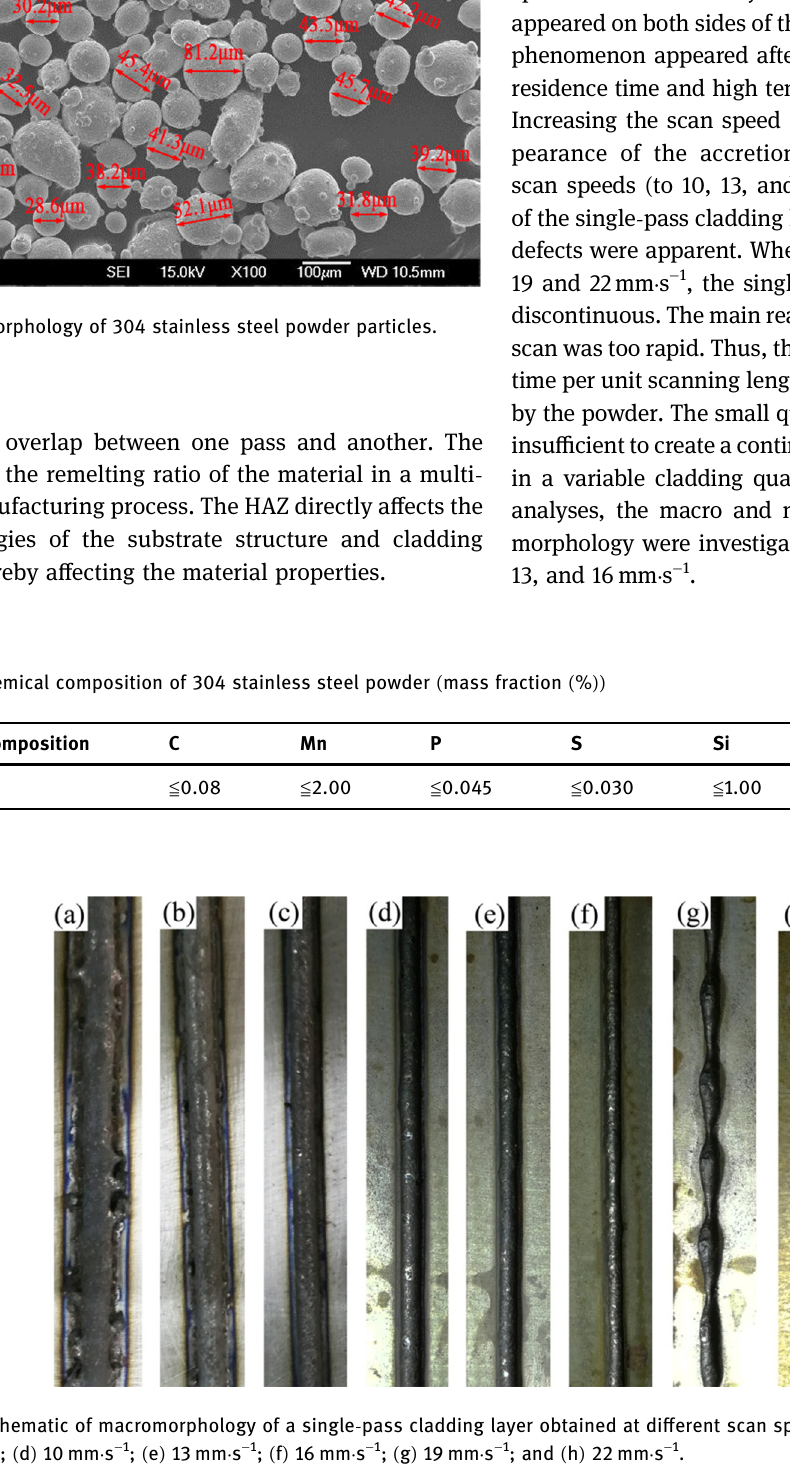
Figure 3: Schematic of macromorphology of a single - pass cladding layer obtained at di ff erent scan speeds. ( a ) 2 mm · s − 1 ; ( b ) 4 mm · s − 1 ; ( c ) 7 mm · s − 1 ; ( d ) 10 mm · s − 1 ; ( e ) 13 mm · s − 1 ; ( f ) 16 mm · s − 1 ; ( g ) 19 mm · s − 1 ; and ( h ) 22 mm · s − 1